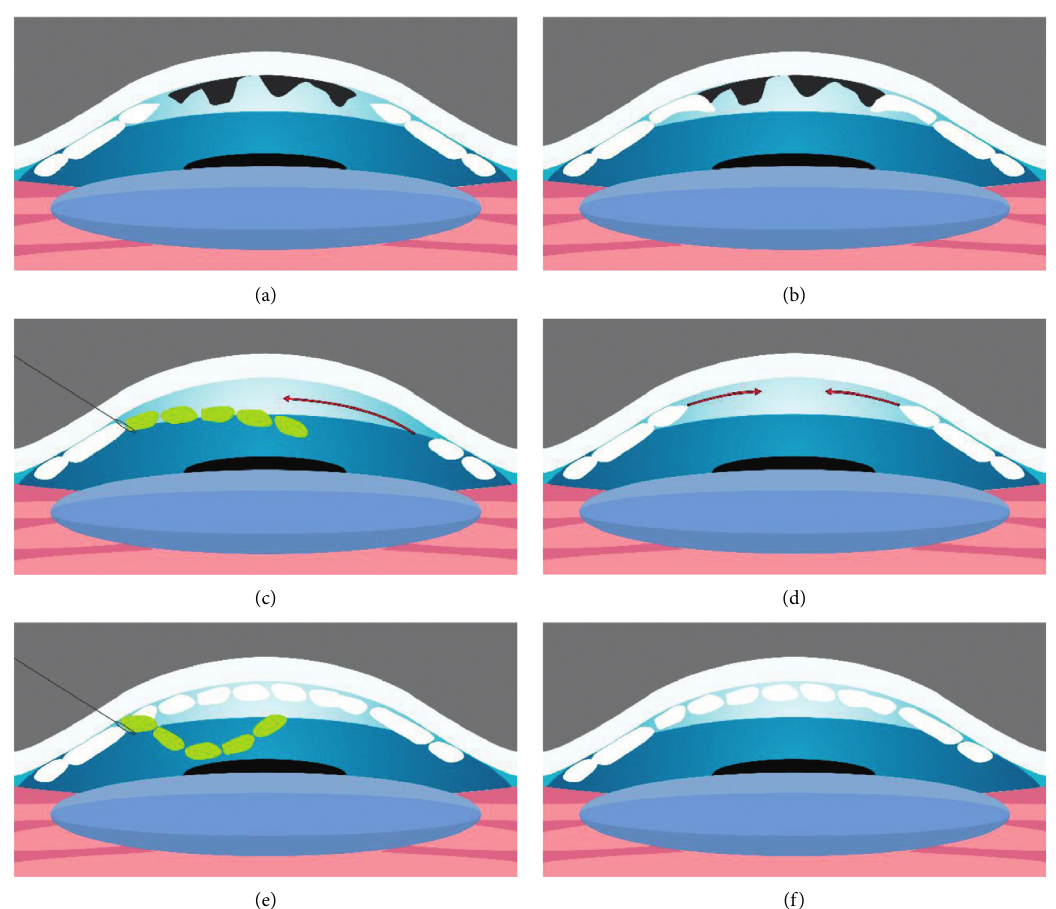
Figure 2: (a, b) Fuchs endothelial dystrophy disease with guttae protruding from the descemet membrane (DM). (a, c, e) The DMET technique. After descemetorhexis, the graft is inserted and fixated to the main corneal incision; the rest of it remains free-floating in the anterior chamber. (d) The DWEK/DSO technique in which a descemetorhexis is performed without further graft implantation. (b, d, f) The DMT technique in which descemetorhexis is performed and a DM graft devoid of endothelial cells is transplanted (based on the articles by Lam et al. and Bruinsma et al. [28, 89]).